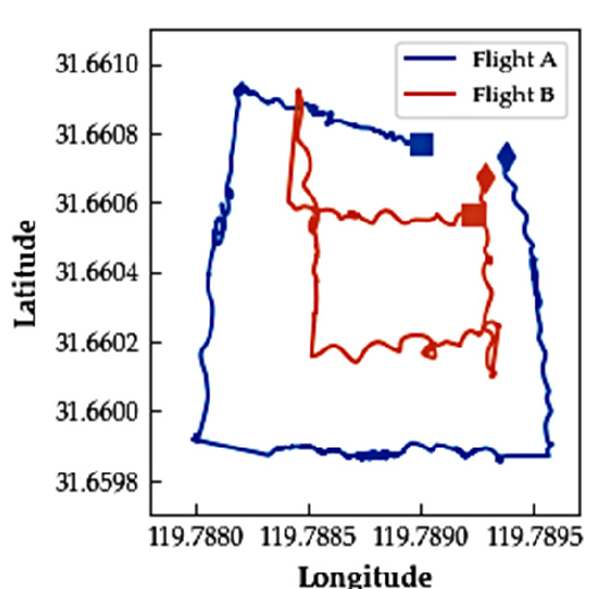
Figure 3. UAV used in FOM flight.